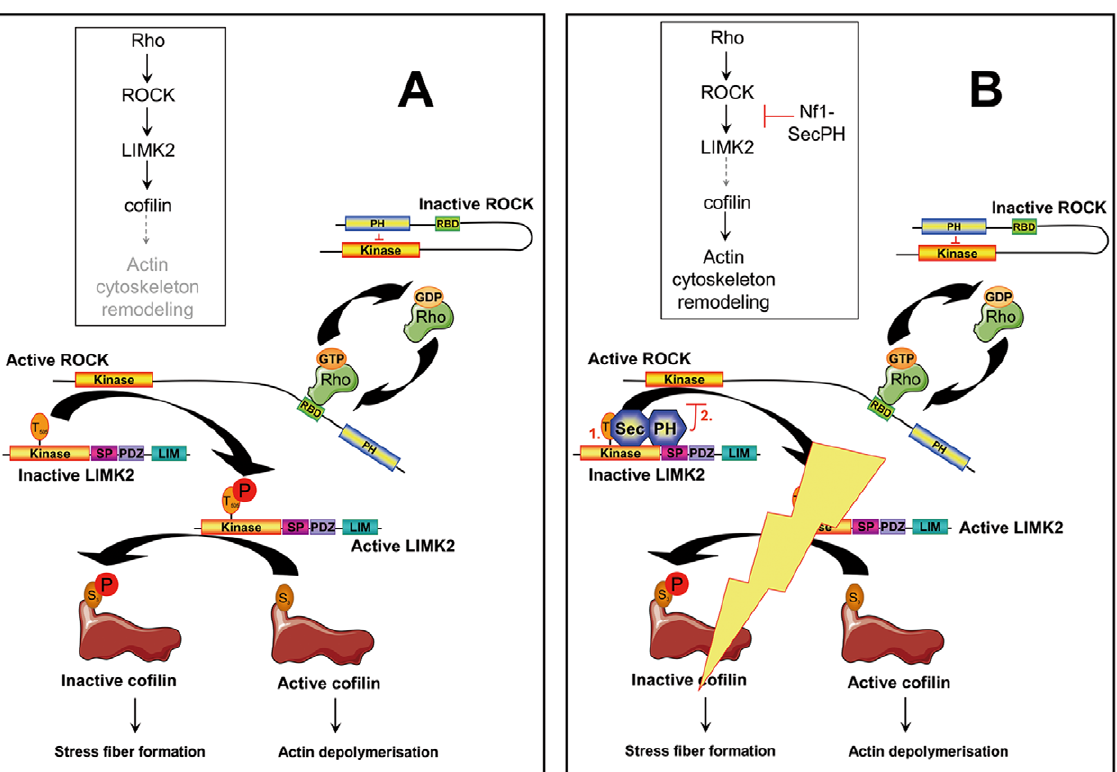
Figure 6. Schematic representation of our findings: A molecular connection between neurofibromin and the Rho/ROCK/LIMK2/ cofilin pathway. A. Upon Rho activation via binding to its RBD (Rho Binding domain), ROCK activates LIMK2 by phosphorylation at its Thr505. Activated LIMK2 will then phosphorylate cofilin on its Ser3, resulting in its inhibition. An invasive phenotype is then observed with accumulation of actin stress fibers. B. SecPH, a new inhibitor of this Rho/ROCK/LIMK2/cofilin pathway . By interacting with LIMK2, SecPH prevents ROCK activation of LIMK2. Our data raises two possible hypotheses for this inhibition of ROCK activation of LIMK2 by SecPH: (1) by steric hindrance, SecPH hides Thr505 of LIMK2 from ROCK accessibility, (2) the PH domain of SecPH substitutes to the PH domain of ROCK by inhibiting the kinase activity of ROCK; this inhibition would specifically occur when ROCK and SecPH are simultaneously bound to LIMK2.